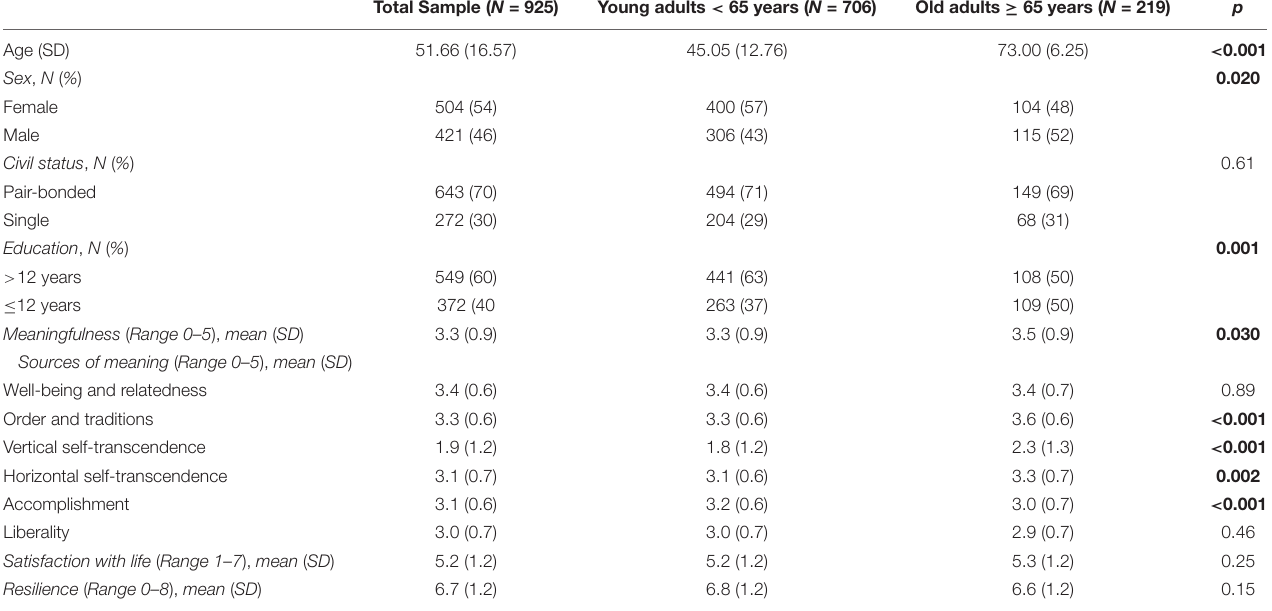
TABLE 1 | Demographics and clinical characteristics of the sample divided into age